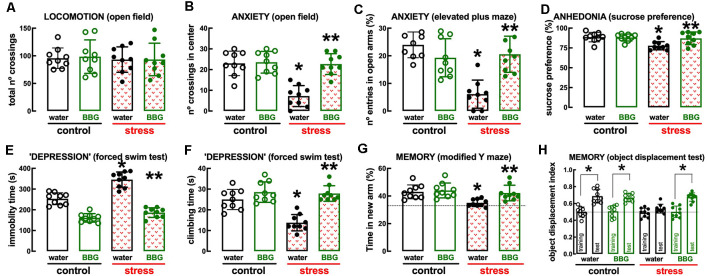
Male adult Wistar rats (8–10 weeks old) subject to a protocol of restraint stress (4 h/day) during 14 days display the expected features of depressed rats, which were prevented by the P2X7 receptor antagonist Brillant Blue G (BBG). Whereas BBG treatment (45 mg/kg, ip, daily, beginning 3 days before the stress protocol and until the sacrifice of the animals; green) was devoid of effects in non-stressed control rats (open bars), BBG prevented all behavioral modifications of stressed rats (red checkered bars): without modification of locomotor activity as evaluated in the open field (A), BBG prevented anxiety-like behavior as evaluated in the open field (B) and in the elevated plus-maze (C) tests, anhedonia as evaluated in the sucrose preference test (D), helpless-like behavior as evaluated by the forced-swimming test (E,F) and impaired memory performance as evaluated by a modified Y maze test (G) and an object-displacement test (H). Data are shown as mean ± SEM; n = 8–9 rats per group. *P < 0.05 vs. control-water, **P < 0.05 vs. stress-water using a Tukey’s multiple comparisons post hoc test after a two-way ANOVA.